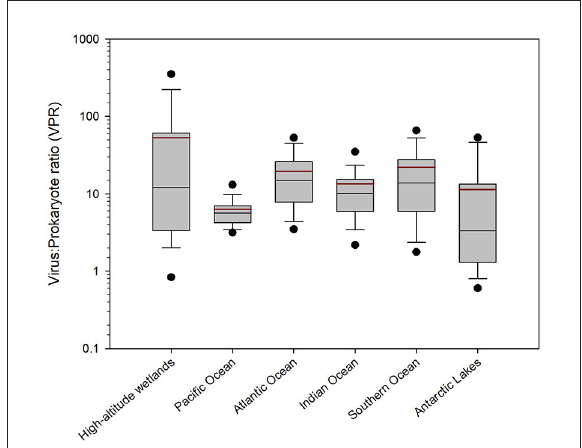
FIGURE6 Boxplot graph of the VPR values of different aquatic ecosystems in the Southern hemisphere. The area of the boxes shows the 25th and 75th percentiles and the whiskers represent 5 and 95% of the data. The thin black line is the median and the thick dark red line is the average. Outliers are shown in black